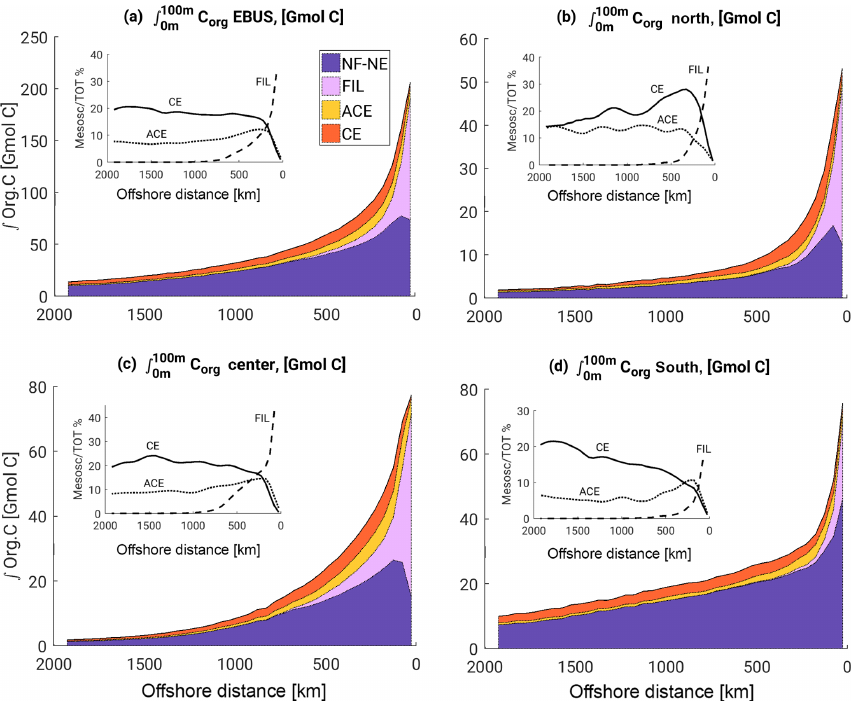
Figure 10. Top 100m organic carbon stock ( R 100m C org ) contained in filaments (FIL), cyclonic eddies (CE), anticyclonic eddies (ACE) and 0 outside of the detected mesoscale structures (NF-NE) by offshore distance. The R 100m C org is integrated across the horizontal extension of 0 (a) the entire Canary EBUS; (b) the northern CanUS; (c) the central CanUS; (d) the southern CanUS. Inserts: Percentage of the total organic carbon stock found within ACE, CE and FIL, by offshore distance; the FIL share of C org in the first 50km offshore is not